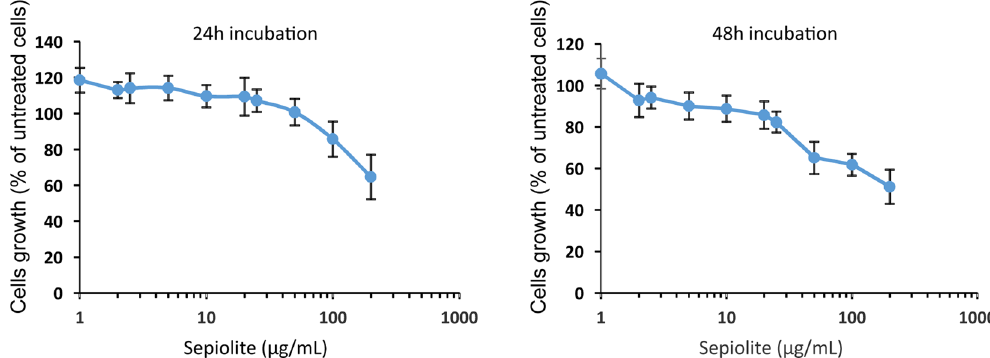
Figure 3. Toxicity of sepiolite. U2OS cells were incubated with increasing quantity of sepiolite for 24 h (left panel) or 48 h (right panel) before MTT test was performed. Each measurement was performed as 8 replicates, and error bare are standard